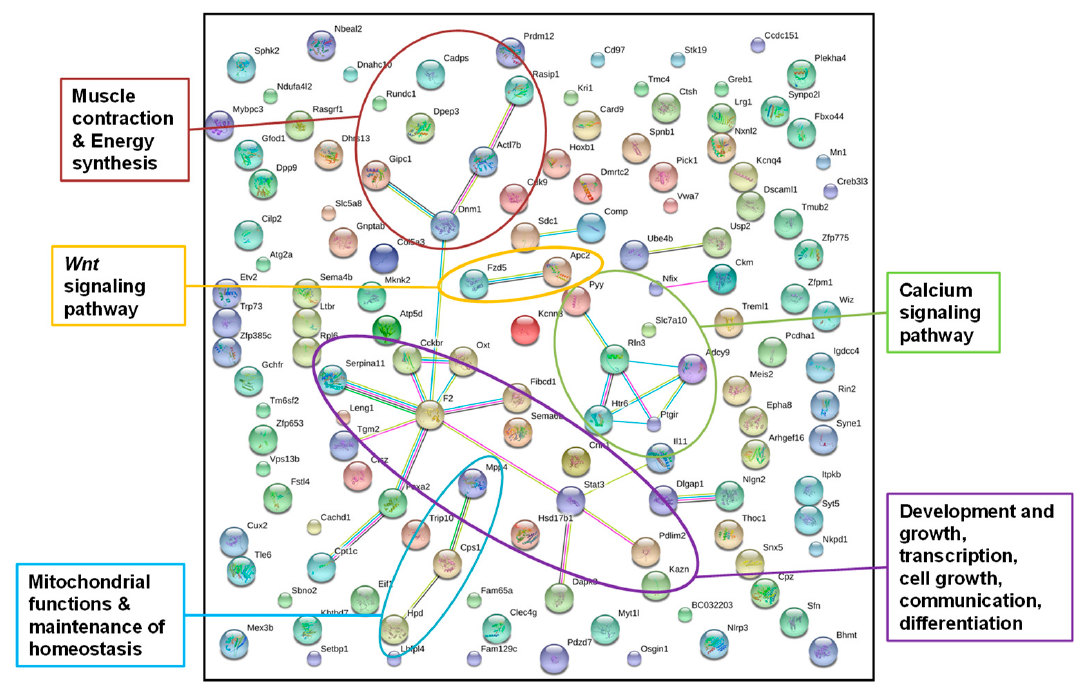
Figure 3. STRING gene network of genes from annotated DMRs in livers of F1 sons after paternal exposure to a low-protein diet; STRING gene network of genes from annotated DMRs detected in the livers of all five father-sorted son groups after paternal diet change (“experiment D”). The main metabolic pathways identified are labeled by colored circles (colors of dots were chosen by the STRING database and do not account for a certain gene function), and connections between dots indicate the interaction of gene products.